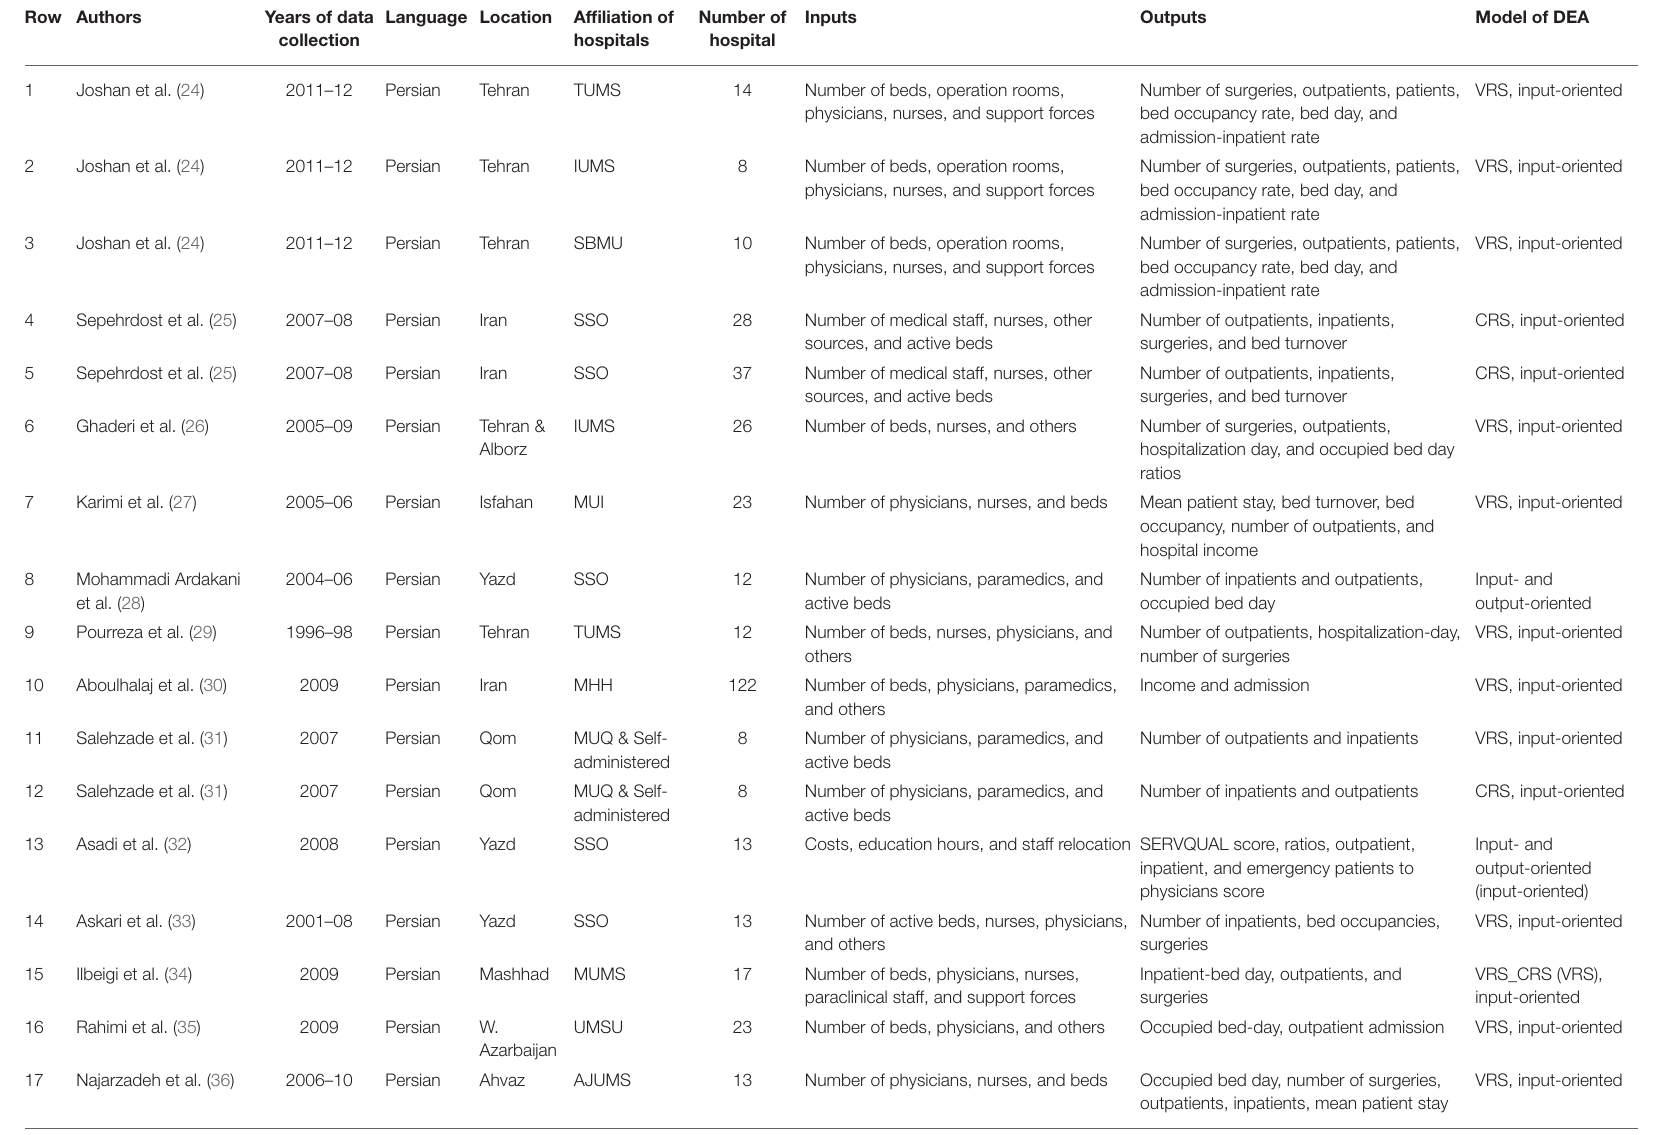
TABLE 1 | Characteristics of the studies included in the systematic review and